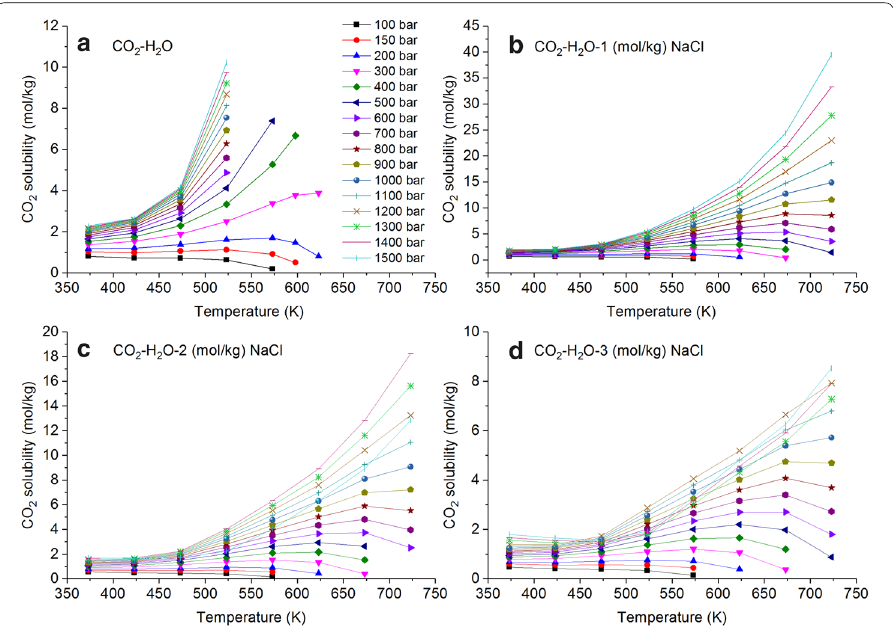
Fig. 8 CO 2 solubility calculations in systems of a CO 2 –H 2 O, b CO 2 –H 2 O–1 mol/kg NaCl, c CO 2 –H 2 O–2 mol/kg NaCl, and d CO 2 –H 2 O–3 mol/kg NaCl. b – d have the same legends as a . The data are derived from Mao et al.